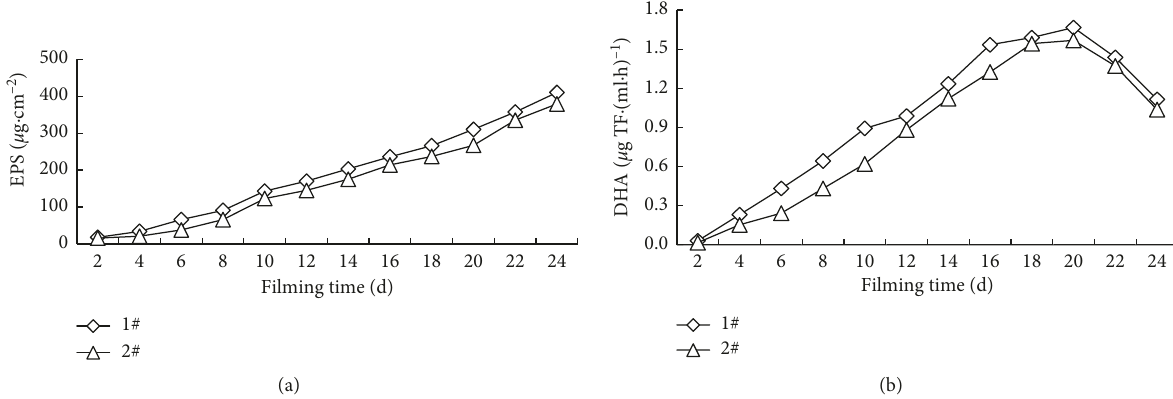
Figure 6: (a) EPS production in the biofilm; (b) DHA production in the biofilm. 1#: the biocarrier was the DSM-derived ceramsite; 2#: the biocarrier was the commercial ceramsite